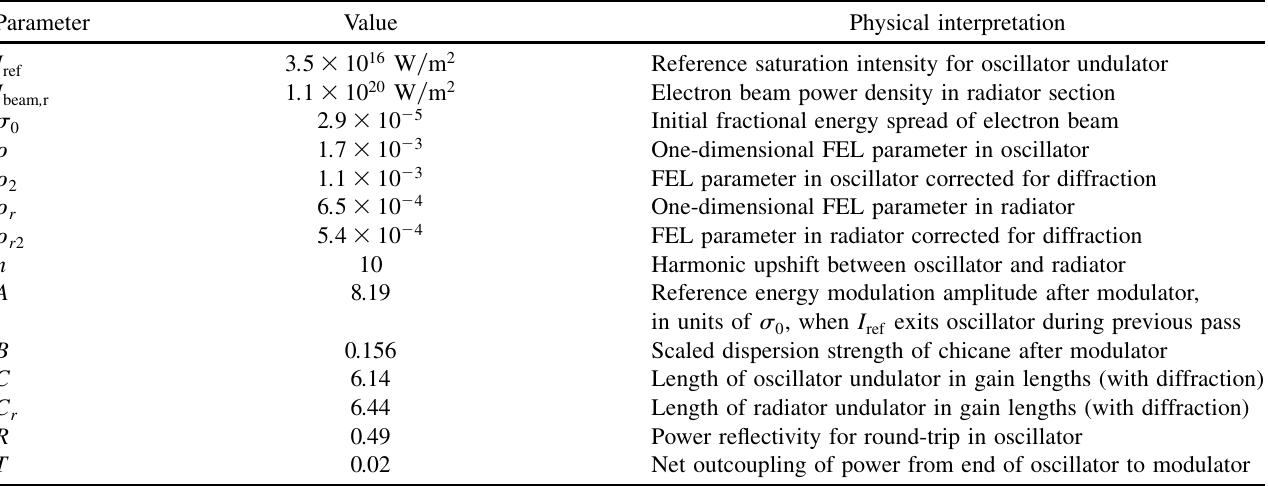
TABLE III. A summary of the parameters used in the map. These values were calculated from the machine parameters as explained in this